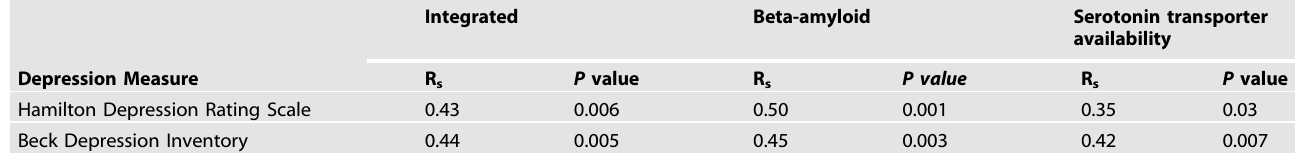
Table 4. Correlation between multi-modal partial least squares (mmPLS) determined subject scores and depression